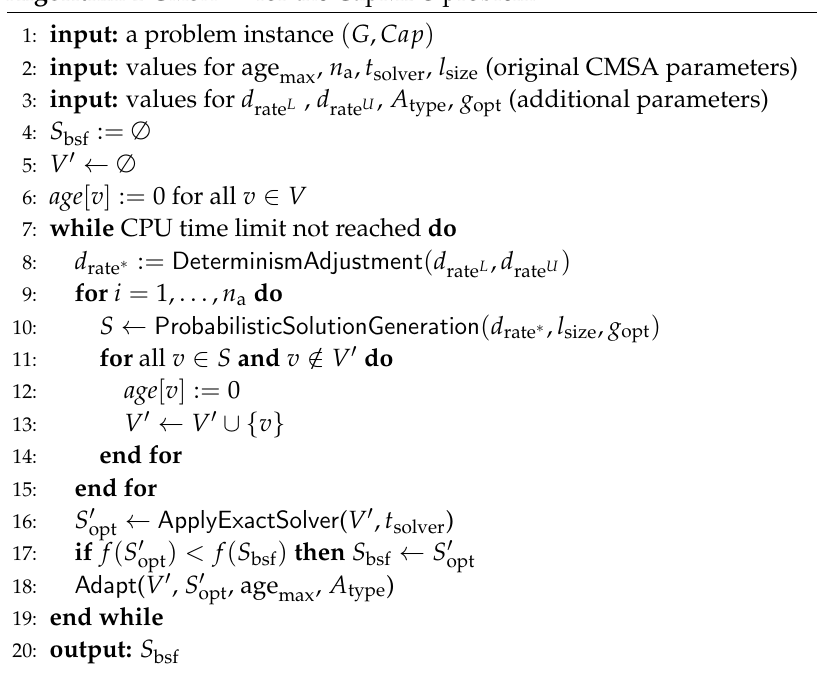
Algorithm 1 C MSA ++ for the CapMDS